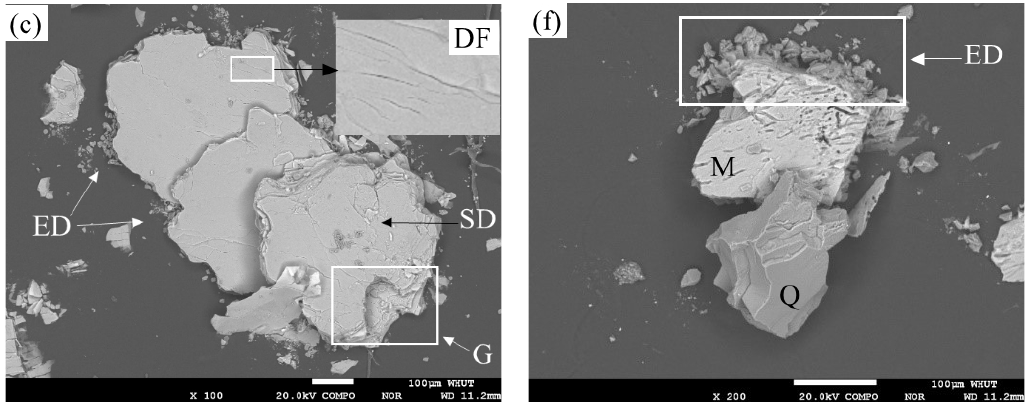
Figure 3. Surface topography of muscovite in leached quartz sand: (1) 0.025 mol/L H 2 SO 4 , 0.050 mol/L NH 4 Cl ( a ) − 150 °C; ( b ) − 200 °C; ( c ) − 250 °C; (2) 0.050 mol/L H 2 SO 4 , 0.100 mol/L NH 4 Cl ( d ) − 150 °C; ( e ) − 200 °C; and ( f ) − 250 °C; SD—surface damage, F—fracture, DF—directional fracture, IF—interlaced fracture, ED—edge damage, M—muscovite, and Q—quartz.